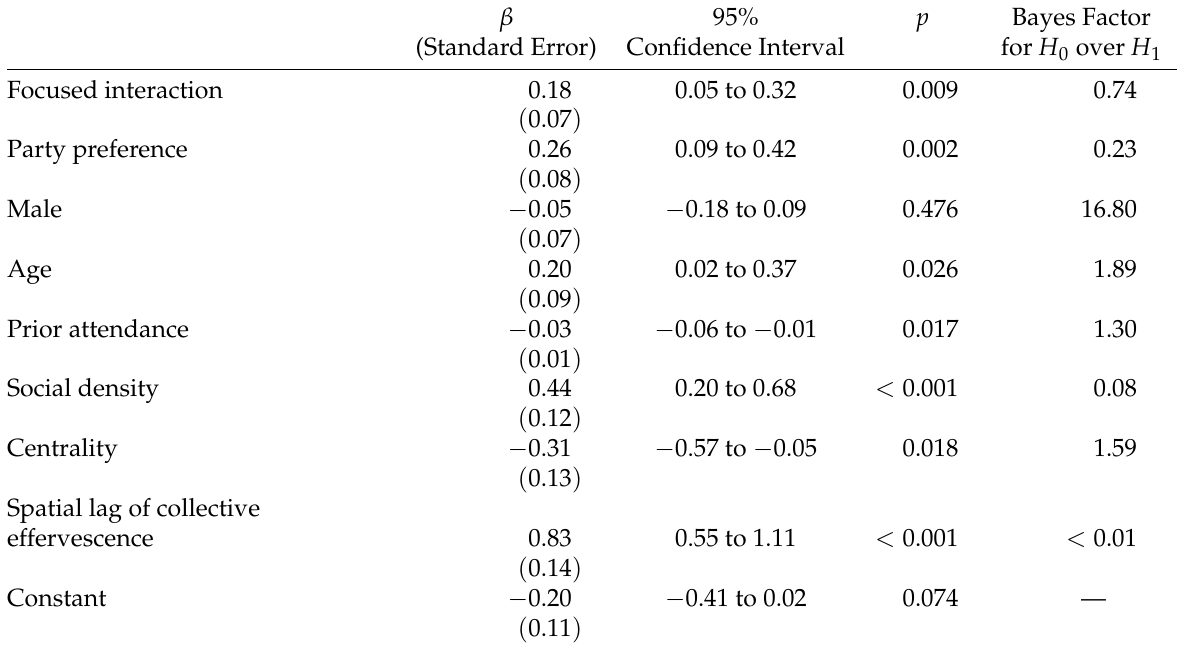
Table 2: Multilevel regression of collective